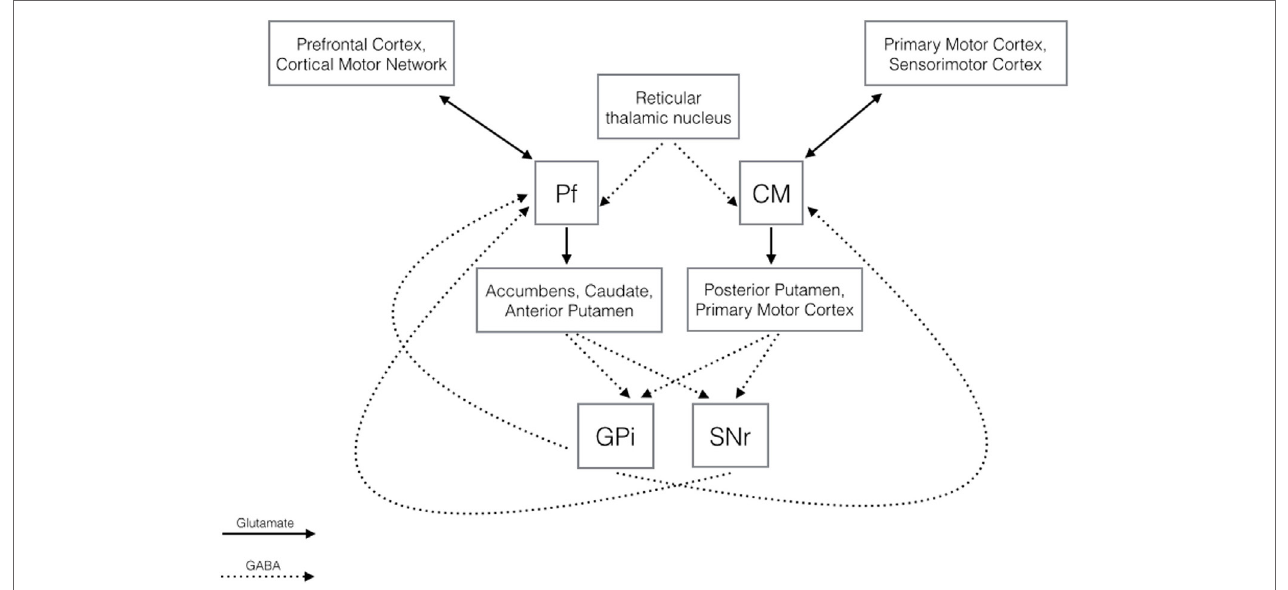
FiGURe 1 | Diagram illustrating the main GABAergic and glutamatergic connections of the centromedian and parafascicular nuclei (21–25) .